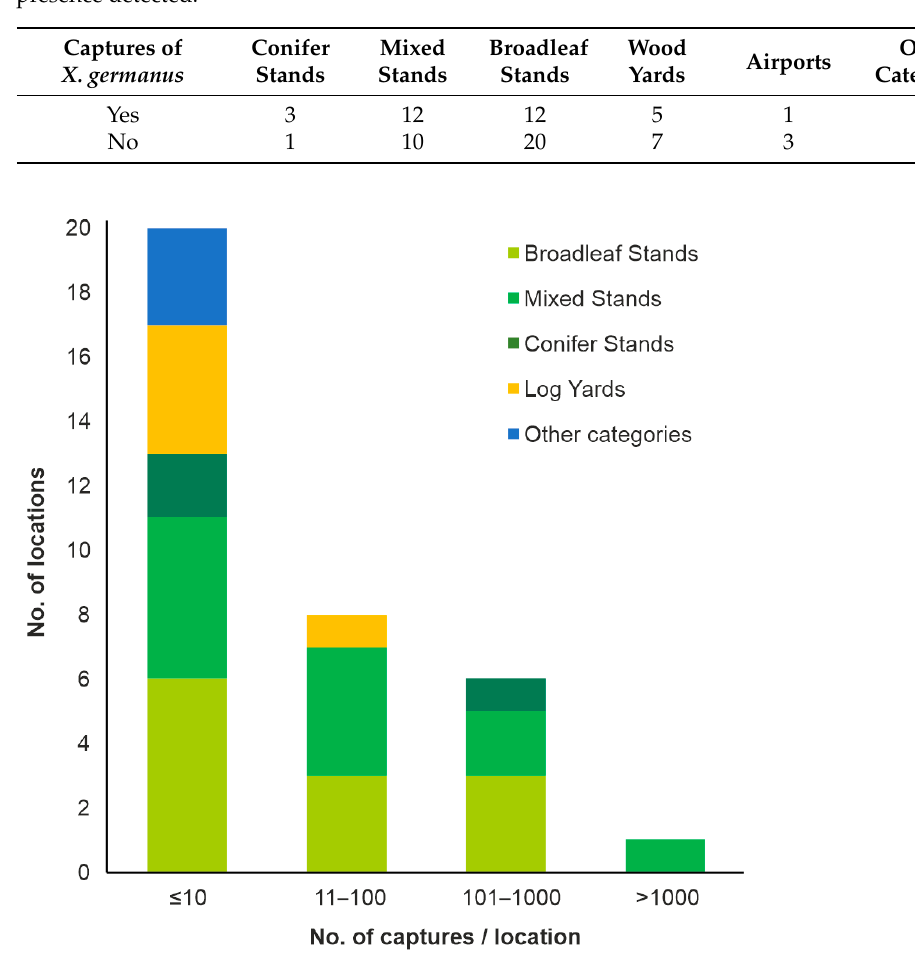
Like NBB, BSB was mainly found in and close to the Carpathian Mountains, in forested areas where the average temperatures in the summer months fall within the range of 16–21 ◦ C. BSB was found in the lowland area and in the floodplain of the Danube in only a few cases and was not collected at all in the most arid regions of the country (Figure 8). Consequently, although BSB catches were recorded from 18 m to 1185 m a.s.l., most of them, both in this study and in our other studies (Table S3), were found at altitudes of 450–920 m (Figure 9). In the case of this species, the higher catches from other studies conducted by us were due to the intentional choice of places with a higher level of populations, to achieve the specific objectives of those